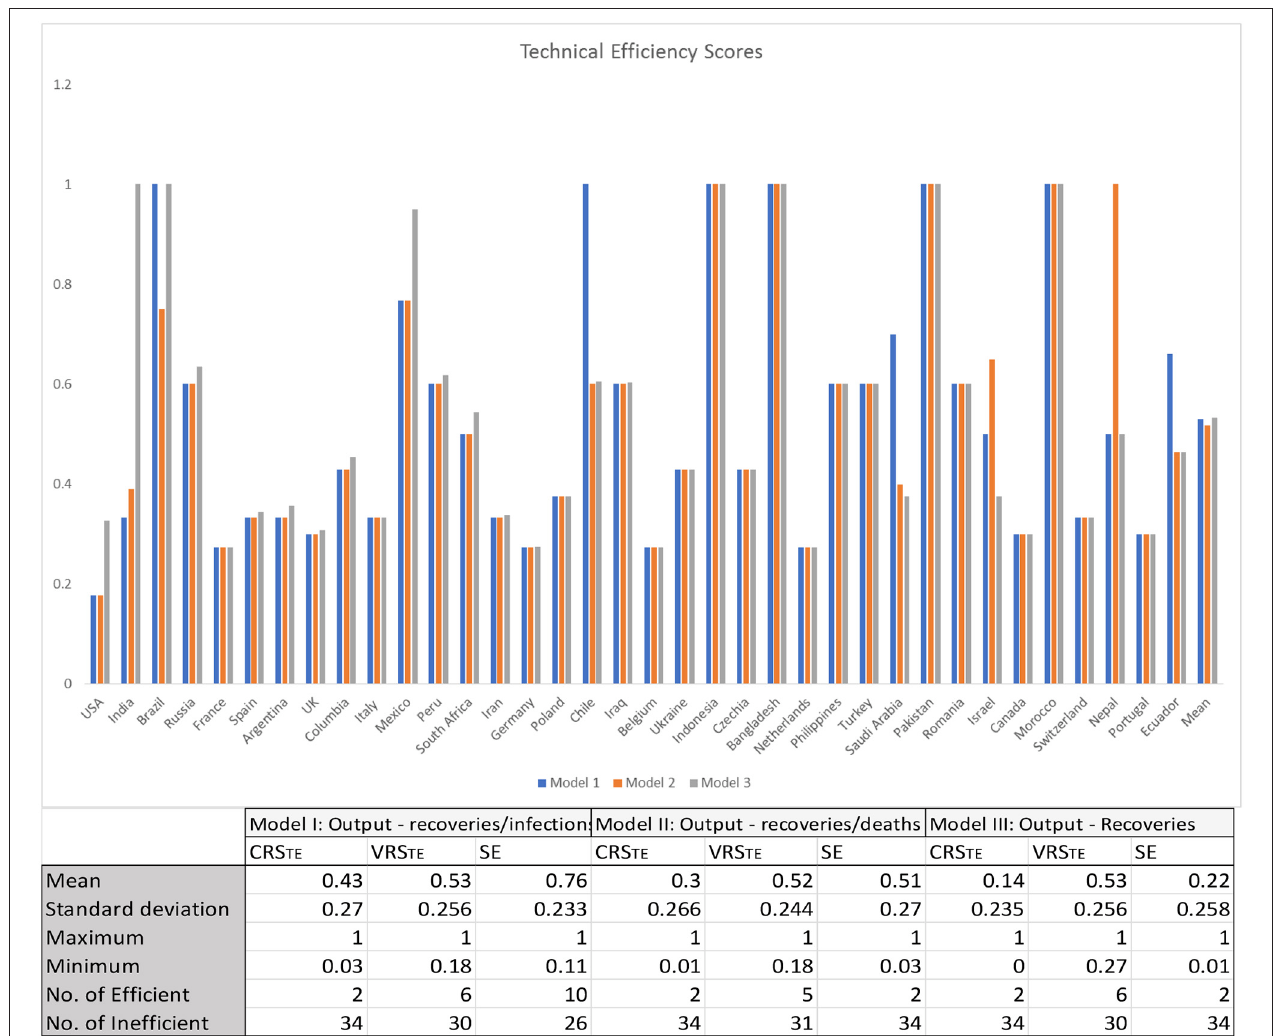
FIGURE 1 | Constant returns to scale and variable returns to scale efficiency scores of global healthcare systems. CRST E represents technical efficiency under constant returns to scale assumption, VRST E represents technical efficiency under variable returns to scale assumption, and SE represents scale efficiency.